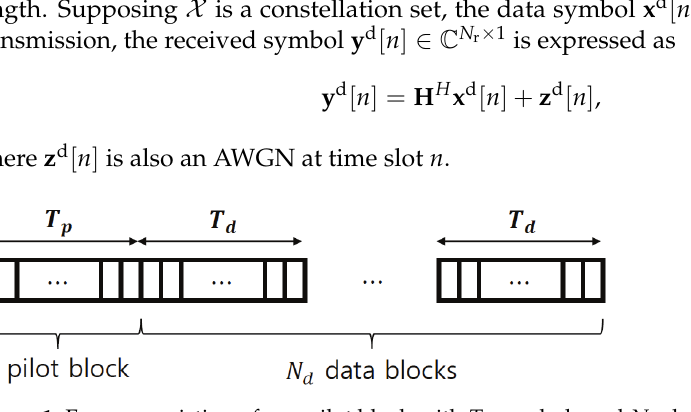
Figure 1. Frame consisting of one pilot block with T p symbols and N d data blocks with T d